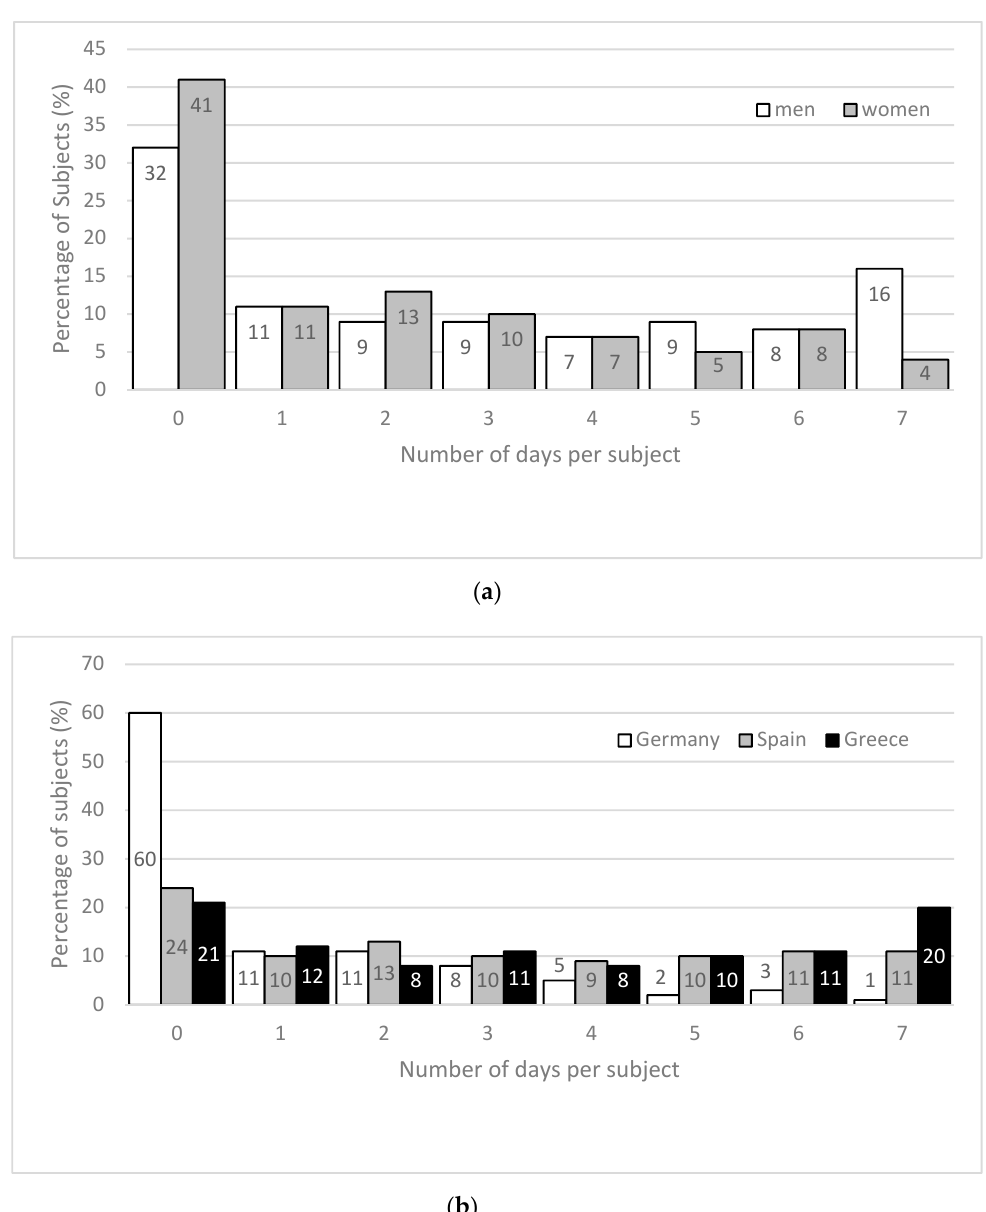
Figure 2. ( a ) Number of days per subject in the seven-day study period with TWI below the EFSA recommendation for men and women; ( b ) number of days per subject in the seven-day study period with TWI below the EFSA recommendation with respect to the country.